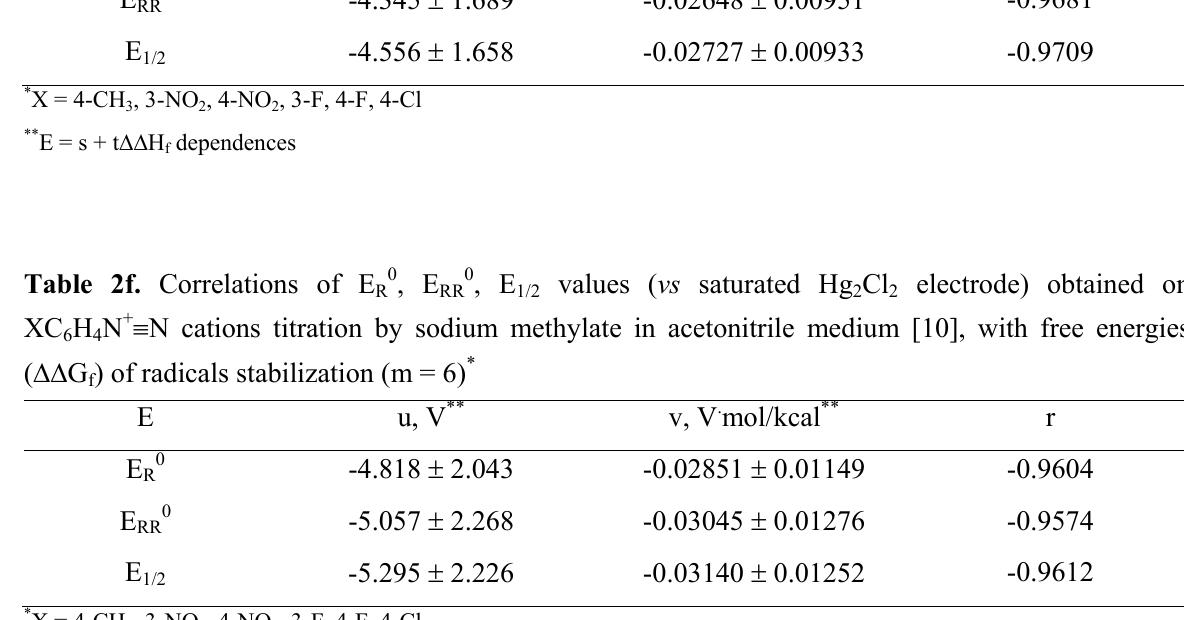
Cl electrode) obtained on 2 2